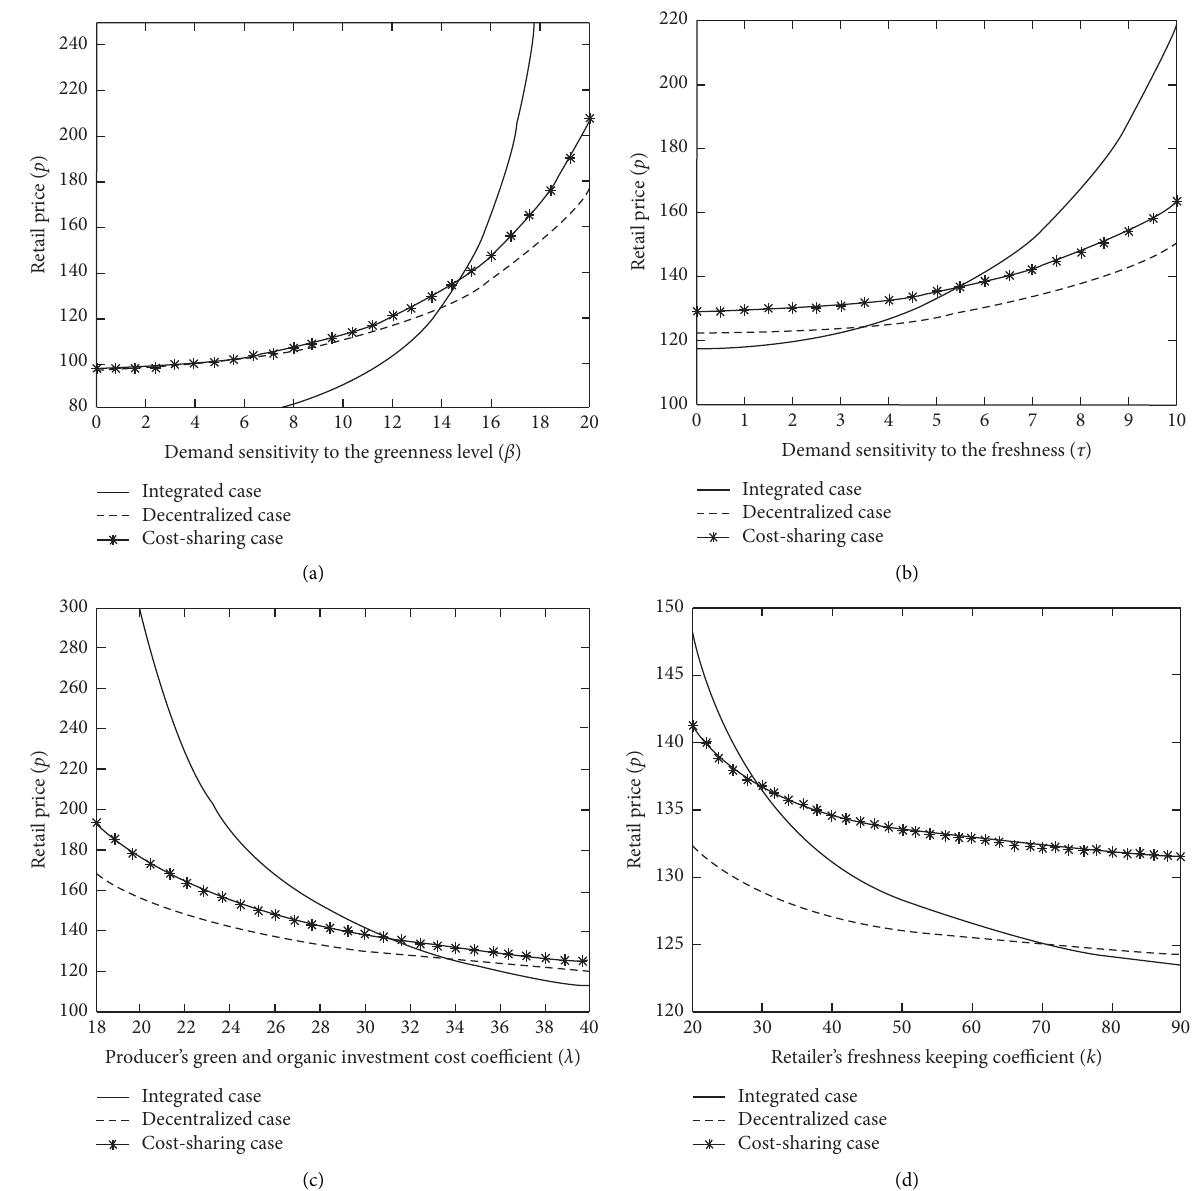
Figure 3: Impact of key parameters on the retail prices under different cases. (a) Retail prices vs. β . (b) Retail prices vs. τ . (c) Retail prices vs. λ . (d) Retail prices vs. k